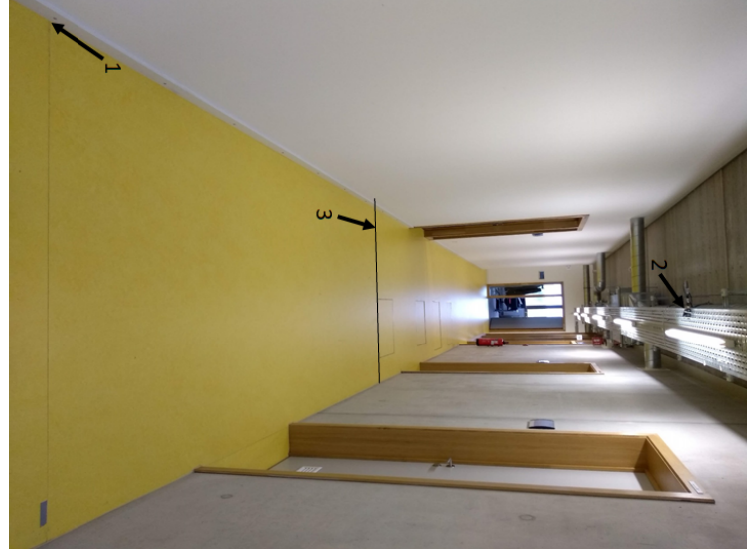
Figure 12. Rotated picture of the office corridor. (1) origin, (2) PD mounted next to light fixture, (3) end of 4 m